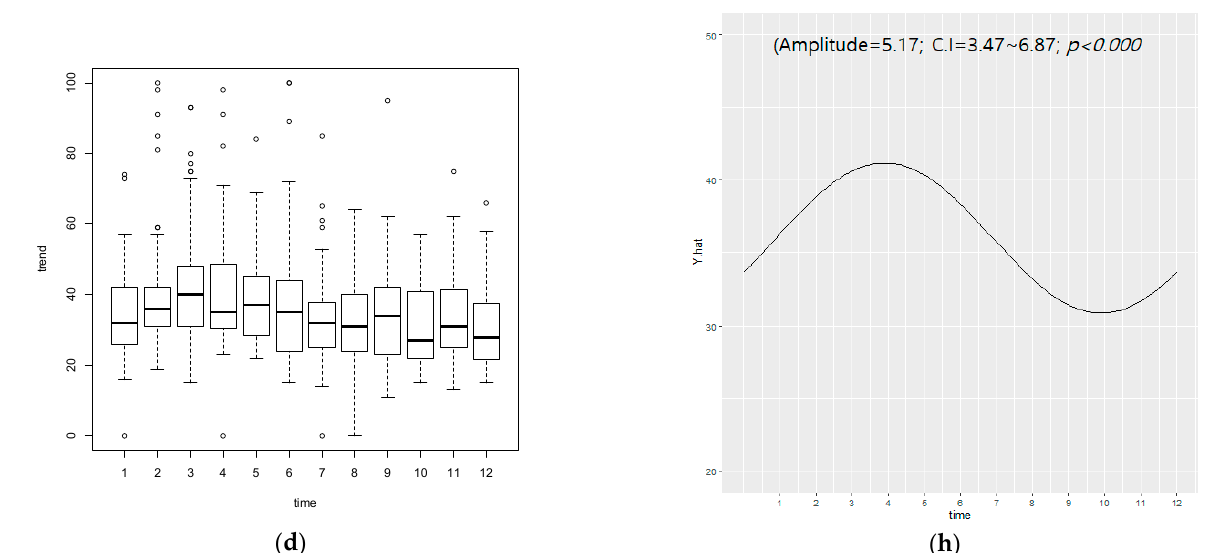
Figure 2. Monthly search volume and cycle for diet in five Arab and Muslim countries. Search volumes of ( a ) the five primarily Arab and Muslim countries in our study and the subcategories ( b ) conservative ( c ) semi-conservative, and ( d ) liberal. Cycle by cosinor analysis of ( e ) five Arab and Muslim countries search volume, ( f ) conservative countries, ( g ) semi-conservative countries, ( h ) liberal countries. C.I: 95% confidence interval; Unit of time is 1 month.; p -value < 0.05 corresponds to the statistical significance of seasonal periodicity of diet interest in each group.